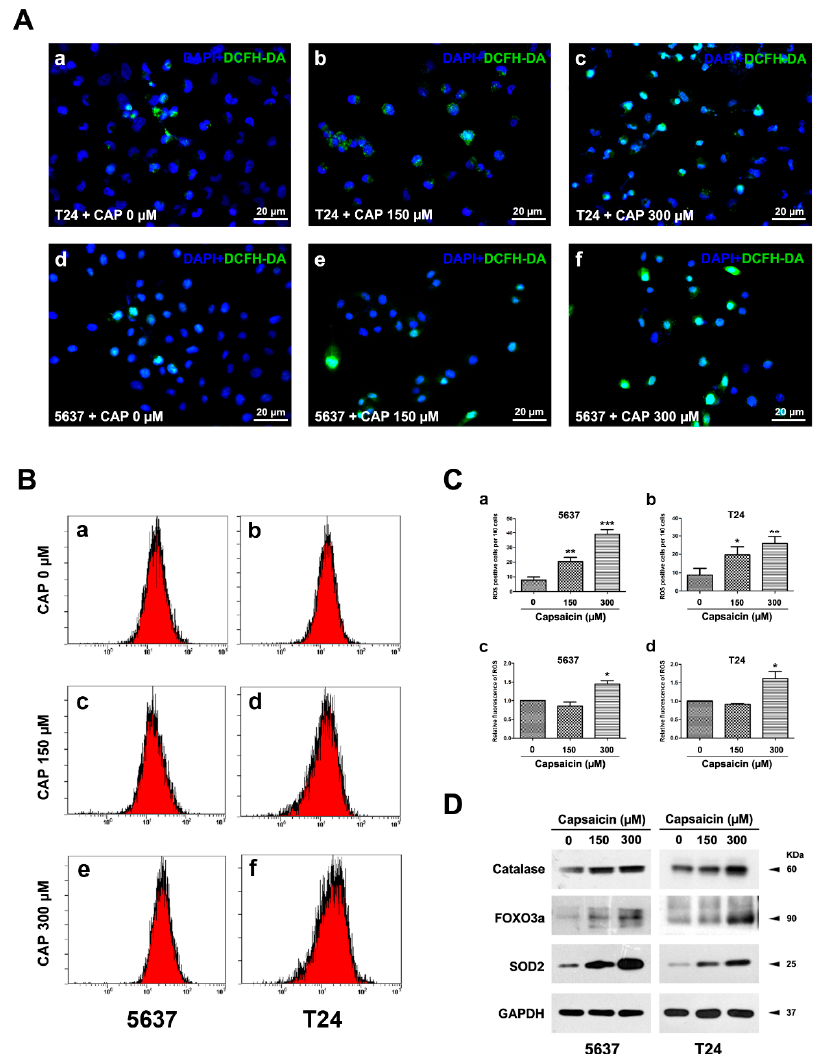
Figure 2. Induction of ROS production and enzymes involved in ROS metabolism by CAP treatment in vitro. ( A ) Representative DCFH-DA staining (green) for ROS production in T24 cells (a–c) and 5637 cells (d–f) treated by CAP at 0, 150 and 300 µM for 48 h. Nuclei were stained by DAPI (blue). The scale bars for (a–f) are 20 µm; ( B ) Representative flow cytometry images for ROS detection by DCFH-DA in 5637 (a,c,e) and T24 cells (b,d,f) by CAP treatment at 0, 150 and 300 µM for 48 h; ( C ) Statistical analysis of cell number with positive DCFH-DA staining (a,b) and relative fluorescence of DCFH-DA using flow cytometry analysis (c,d), indicating significantly increased DCFH-DA positive BCa cells after CAP treatment. Results shown were mean ± SD of triplicate measurements and repeated three independent experiments. * p < 0.05, ** p < 0.01, *** p < 0.001; ( D ) Western blot analysis revealed a strong upregulation of proteins involved in ROS metabolism: Catalase, FOXO3a, SOD2. GAPDH was used as a loading control. Cell types, CAP concentrations and protein masses were indicated.